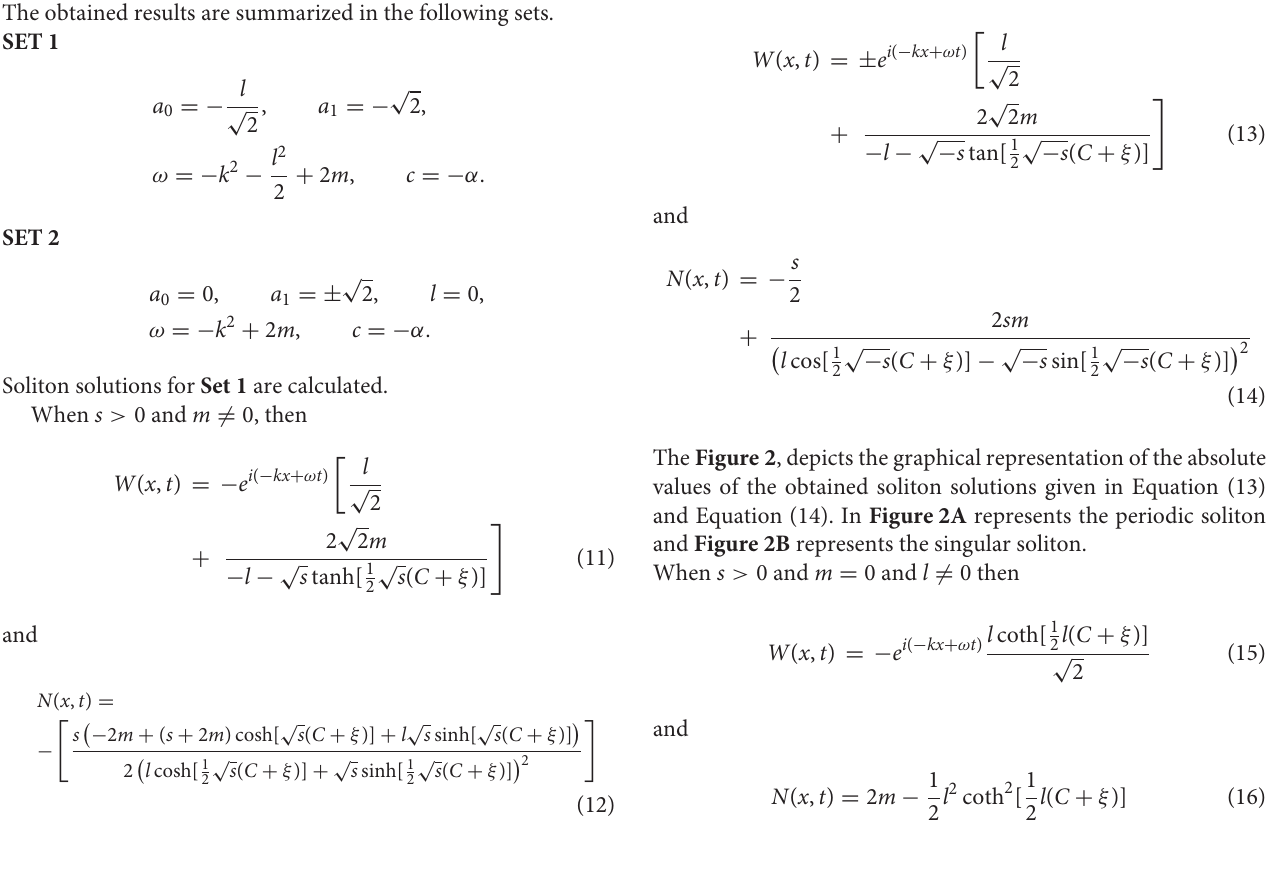
3, s 1, m 2, k 1, ξ x 2t = = = = = +